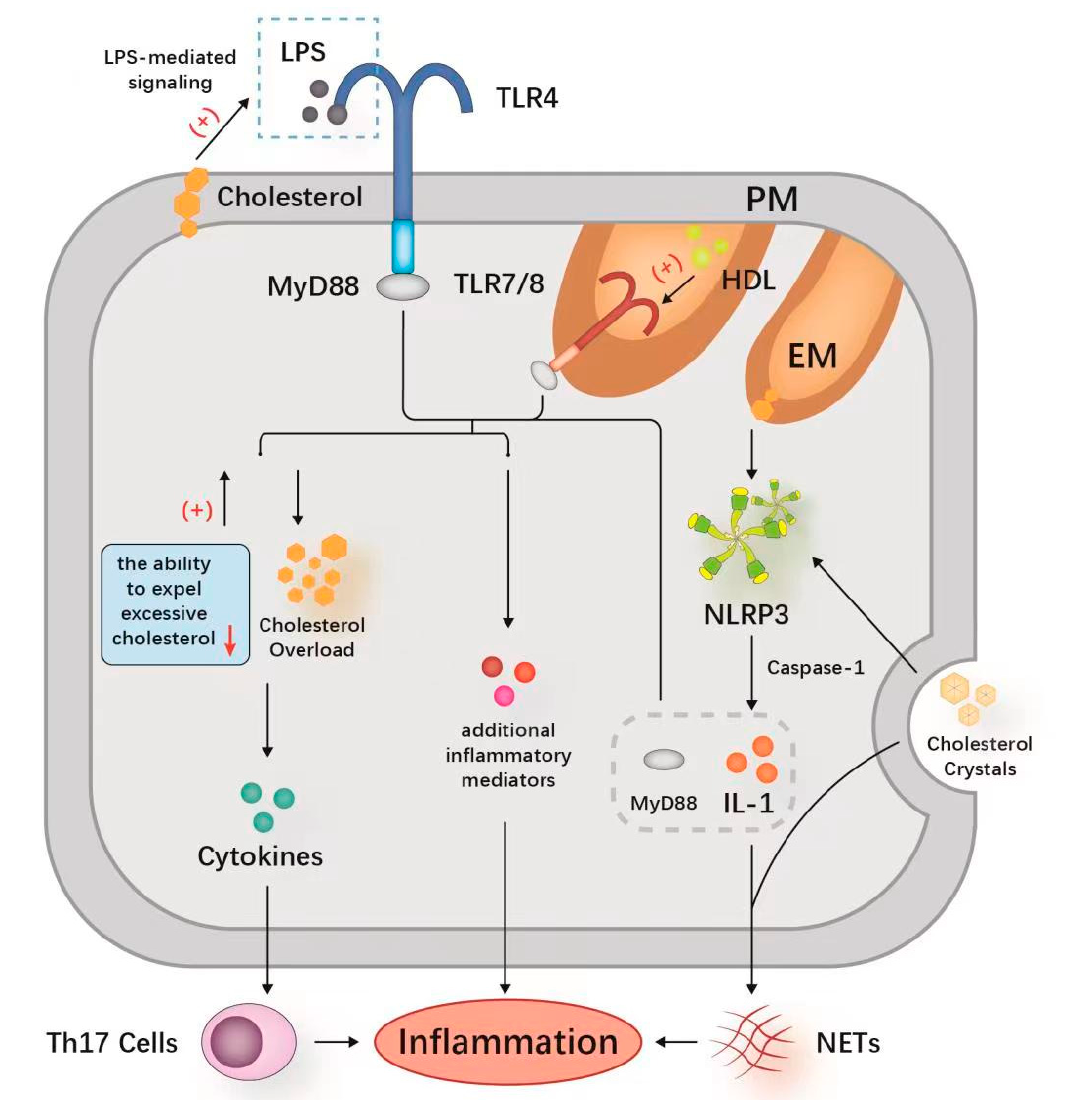
Figure 3. Mechanisms of inflammation caused by abnormal cholesterol. Cholesterol could promote inflammation by activating the TLR signaling pathway to facilitate the release of pro-inflammatory cytokines, and the TLR signaling could be amplified by excess cholesterol in macrophages to exacerbate the inflammatory response. The NLRP3 can be activated by cholesterol and releases IL-1 via the caspase-1-mediated pro-inflammatory IL-1 signaling pathway. IL-1 released after NLRP3 activation shares the intracellular signaling domain with TLRs, inducing MyD88 to produce additional inflammatory mediators that aggravate the inflammatory response. Cholesterol induces the release of NETs, which in turn stimulate macrophages to produce cytokines that activate TH17 cells. The formation of NETs is also associated with the activation of NLRP3. These mechanisms of action do not exist independently but instead are closely related to each other, thereby exacerbating the cholesterol- induced inflammatory response. Abbreviations : TLR, toll-like receptor; LPS, lipopolysaccharide; TIR, Toll/IL-1 receptor; IL-1 β , interleukin-1 β ; MyD88, major reactive protein 88; NETs, neutrophil extracellular traps; PM, plasma membrane; ER, endoplasmic reticulum; TH17, T-helper cell 17; HDL, high-density